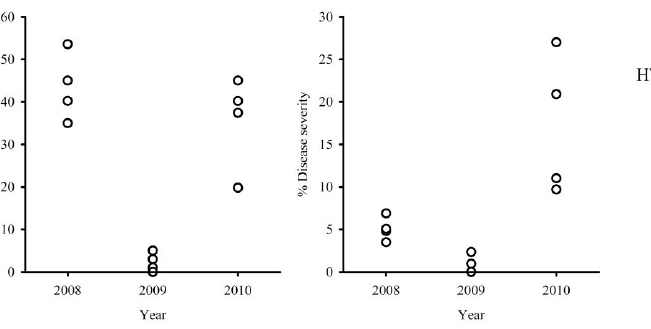
Fig. 1: Incidence and severity of Fusarium head blight on durum wheat cultivar Simeto grown in a field near Bologna, Italy